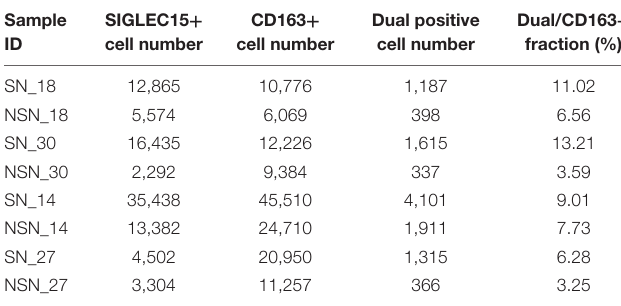
TABLE 2 | The co-expression of SIGLEC15 and CD163 in lymph nodes.